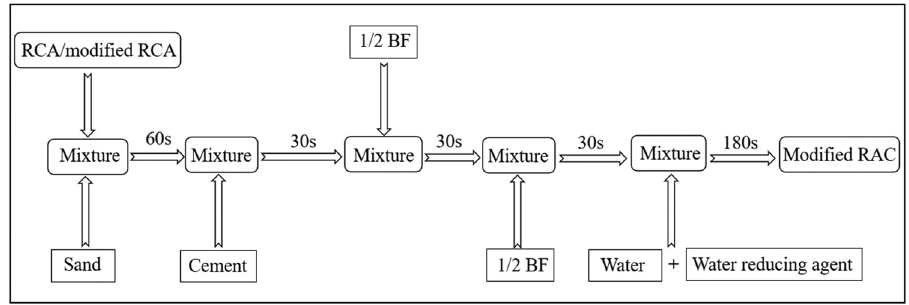
Figure 3: Determination process of crushing value of RA. ( 1 ) Sample and put into the mold; ( 2 ) apply load; ( 3 ) sieve the sample.